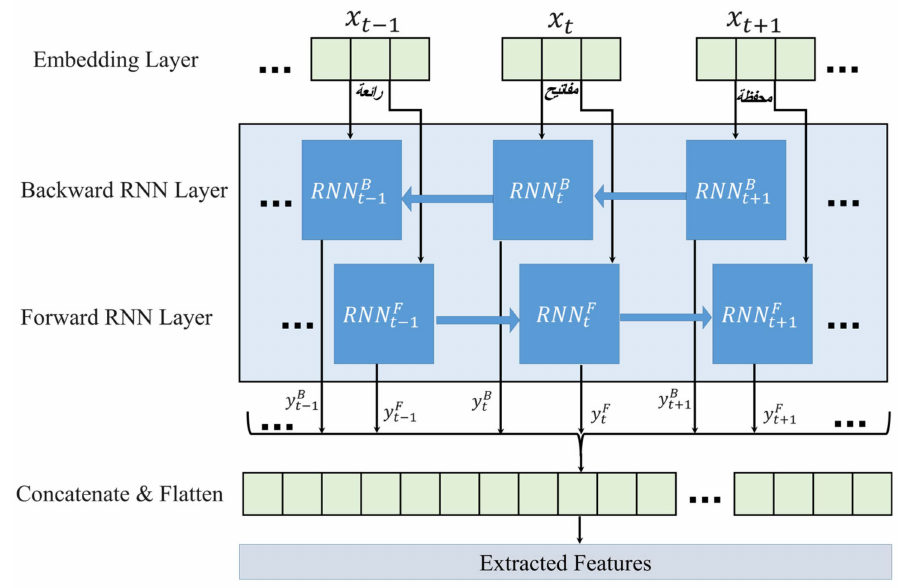
Figure 3. Proposed architecture of the deep recurrent neural network model for feature extraction from Arabic text (‘ ةعئار ' حيتافم ةظفحم ‘ means ‘keys wallet is amazing’ ).